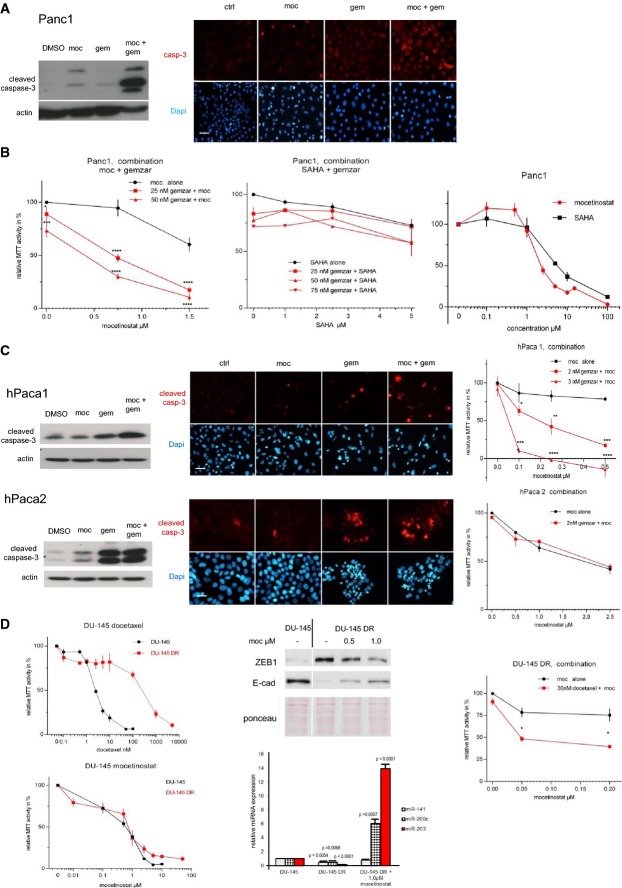
Mocetinostat sensitizes to gemcitabine in vitro

Immunoblot and immunofluorescence for cleaved caspase-3 showing strong increase in apoptosis in gemcitabine-resistant Panc1 after combined treatment with mocetinostat (1 μM) and gemcitabine (50 nM). Scale bar 20 μm.

MTT assay for Panc1 treated with the indicated concentrations of mocetinostat (left) or SAHA (middle) and gemcitabine (72 h). Combined treatment of mocetinostat and gemcitabine significantly reduced cell viability. In contrast, a combination with SAHA had no effect. For calculation of the CI and synergy between the drugs, see Table2. Comparison of mocetinostat and SAHA alone (right). n = 3, mean ± SEM, Dunnett's multiple comparisons test (P-values in the graphs are ***P < 0.001 and ****P < 0.0001; for exact P-values, see Supplementary Table S4).

Effects of mocetinostat on cleaved caspase expression and susceptibility to gemcitabine in the patient-derived pancreatic cancer cells. Note that hPaca1 behaves similar to Panc1, but mocetinostat had no significant effect in hPaca2. Scale bar 20 μm. n = 3, mean ± SEM, Dunnett's multiple comparisons test (P-values in the graphs are *P = 0.01–0.05, **P = 0.001–0.01, ***P < 0.001, and ****P < 0.0001; for exact P-values, see Supplementary Table S4).

MTT assays comparing the effects of docetaxel and mocetinostat in the prostate cancer cell line DU-145 and the docetaxel-resistant subclone DU-145 DR (left). Mocetinostat treatment of DU-145 DR downregulates ZEB1, upregulates E-cadherin, miR-200, and miR-203 expression. For relative miRNA expression, the expression levels in original DU-145 were set to 1 (middle panels, the immunoblot panel derives from the same experiment shown in Fig1A). Mocetinostat sensitizes DU-145 DR to docetaxel (right). For calculation of the CI and synergy between the drugs, see Table2. n = 3, mean ± SEM, Dunnett's multiple comparisons test (P-values in the graphs are *P = 0.01–0.05; for exact P-values, see Supplementary Table S4).

Source data are available online for this figure.